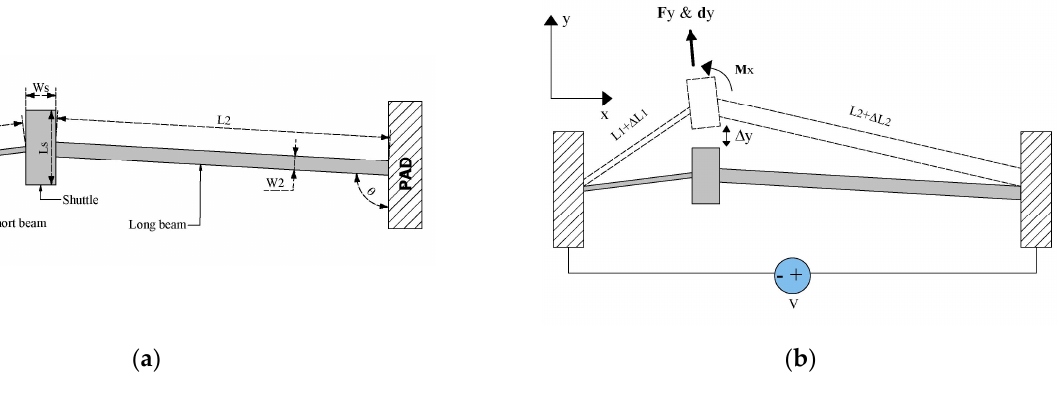
Figure 1. ( a ) Elements and geometric sizes, and ( b ) operating conditions of the asymmetric micro- actuator.